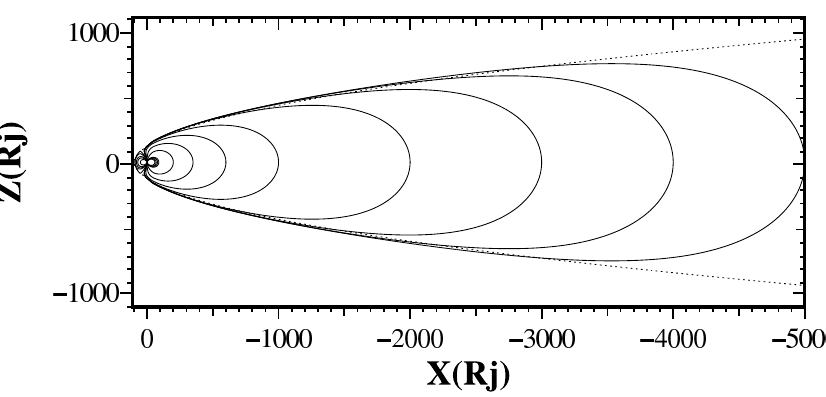
Fig. 2. The Jovian dipole field and the field of the Chapman–Ferraro magnetopause current which shields the dipole field in the noon-midnight section of Jupiter’s magnetosphere. The normal to the magnetopause component of the total field B n = 0. Outside the magnetopause, the magnetic field equals zero. The magnetopause is marked by the dotted curve. Along X and Y axes there are distances in Jovian radii. Model parameters are: 9 = 0; R ss = 100 R J . At the distant low-latitude, the nightside magnetosphere magnetic field is southward.